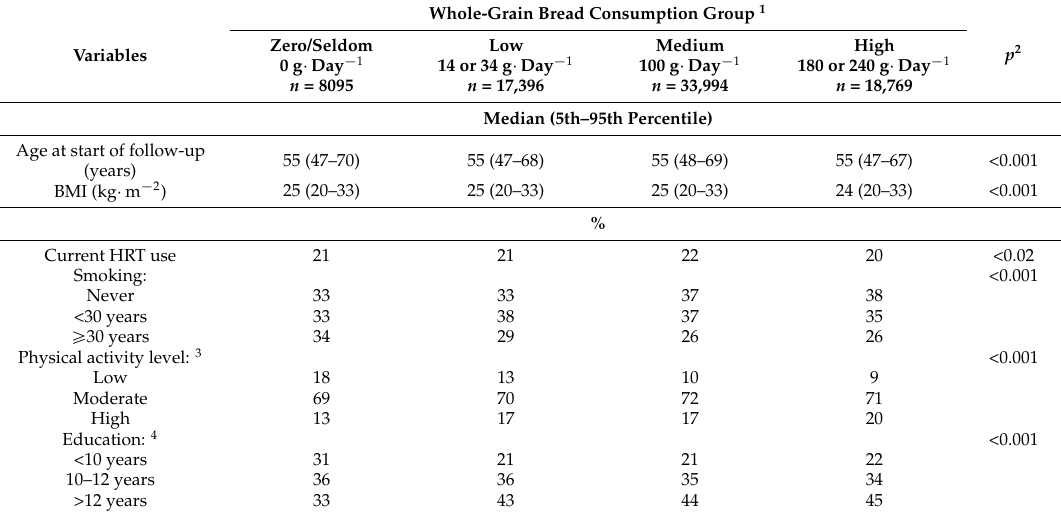
Table 1. Baseline characteristics (2002–2006) of the study sample (Norwegian Women and Cancer Study), n =